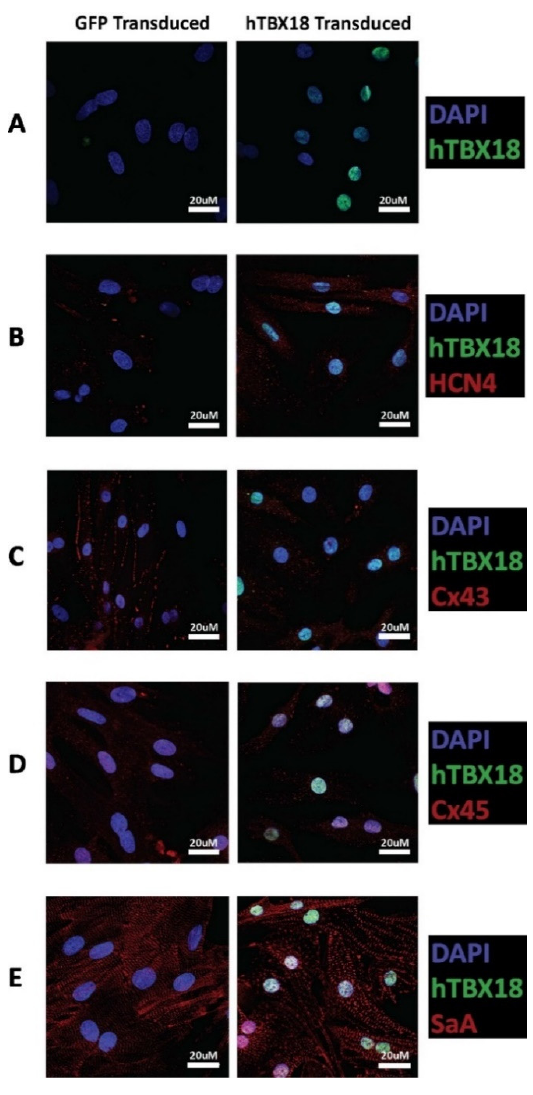
Figure 4. Characterization of expression levels of pacemaker markers in rAAV6-GFP and rAAV6- hTBX18 -transduced cells by immunocytochemistry. ( A ) hTBX18 (green) expression and ( B ) HCN4 (red) and hTBX18 (green) expression. ( C ) Cx43 (red) and hTBX18 (green) expression. ( D ) Cx45 (red) and hTBX18 (green) expression. ( E ) S α A (red) and hTBX18 (green) expression. All samples were also co-stained with DAPI to mark the nuclei (blue).